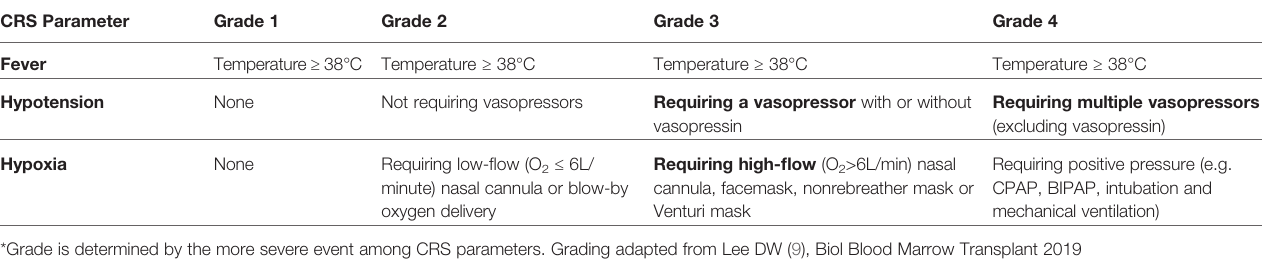
TABLE 3 | CRS grading and